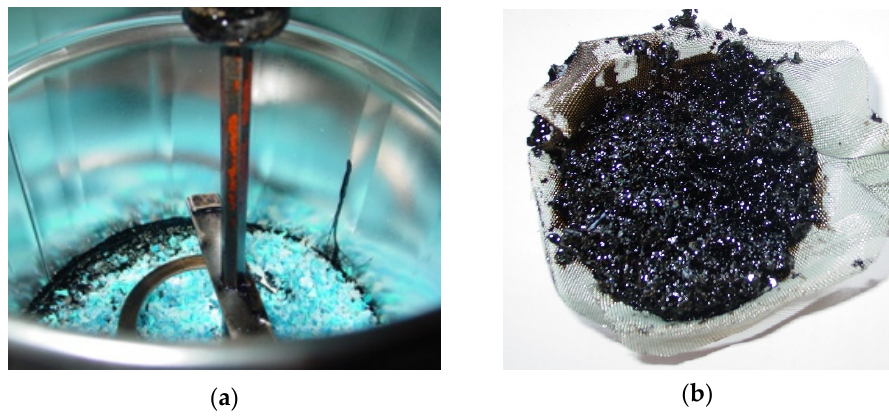
Figure 2. Evaluation of PEX interaction with bitumen: ( a ) Binder preparation for 2 min at 180 °C and; ( b ) The binder was filtered to separate the cross-linked part of PEX undissolved in bitumen.